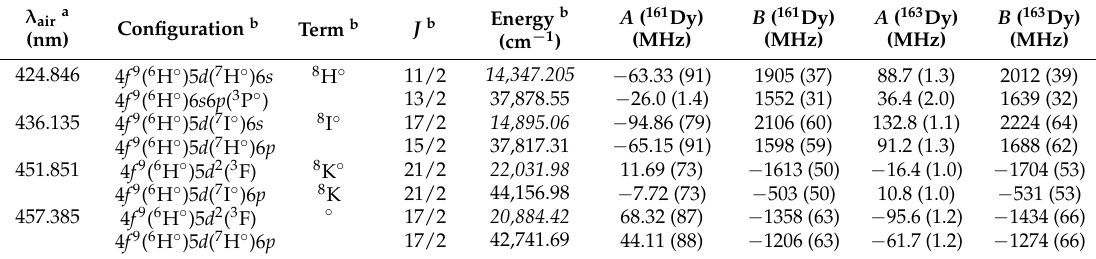
Table 3. Hyperfine structure constants of transitions of 161 Dy II and 163 Dy II where satellite peaks are not well fit. A and B are the magnetic dipole and electric quadrupole constants, respectively. J is the total angular momentum. Energies of odd-parity levels are italicized.